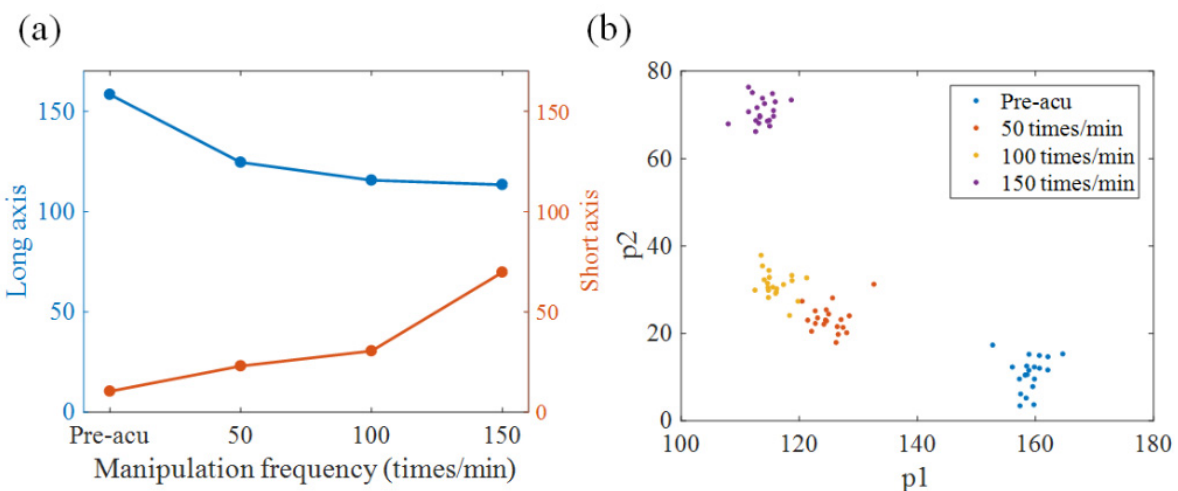
Figure 8. Statistical analysis of attractors of different states. ( a ) Dependence of long and short axes on manipulation frequency. ( b ) Cluster of manipulation operation based on attractors. The statistics of attractors can be discriminants for different brain states. Table 1. ANOVA 1 analysis for comparison of the length of the long and short axes in different states.